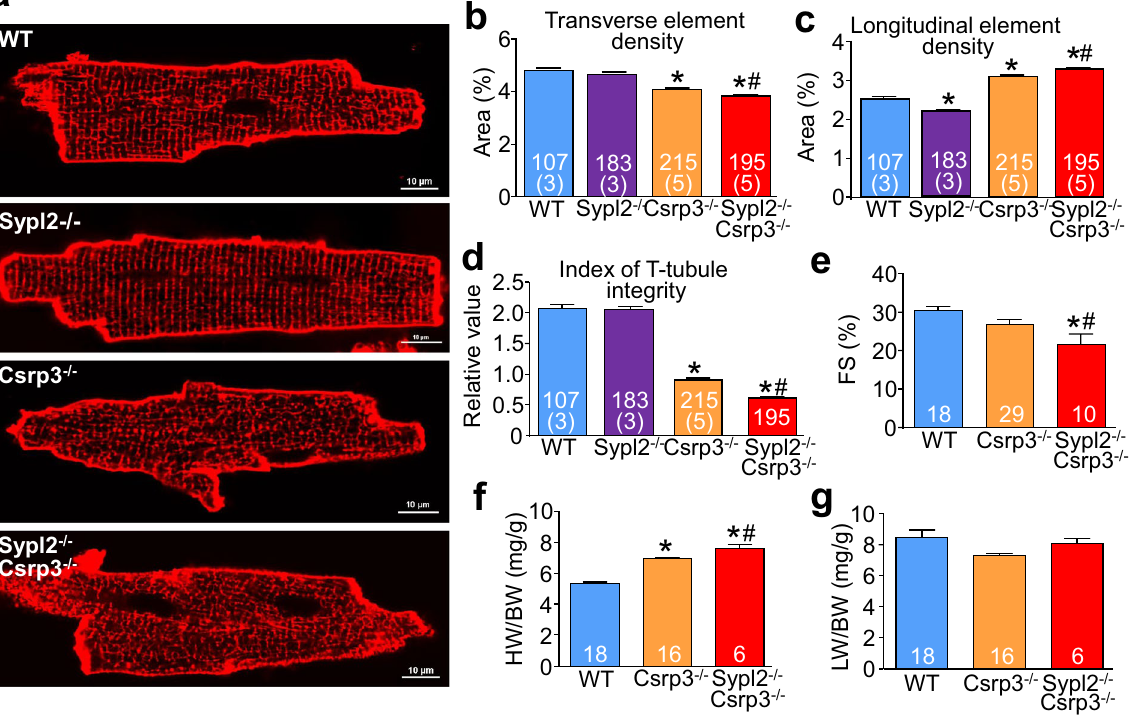
Figure 5. Loss of Mg29 accelerates heart failure progression in Csrp3 − / − mice. ( a ) Confocal images of di-8- ANEPPS-loaded cardiomyocytes isolated from Csrp3 − / − , Sypl2 − / − , Csrp3 − / − Sypl2 − / − and WT control mice. Densities of cardiomyocyte transverse t-tubule elements ( b ), longitudinal t-tubule elements ( c ), and combined measures of t-tubule integrity ( d ) were generated using AutoTT software. ( e ) Cardiac function as assessed by echocardiographic measures of fractional shortening, ( f ) heart weight normalized to body weight (HW/BW), and ( g ) lung weight normalized to body weight (LW/BW) from Csrp3 − / − , Csrp3 − / − Sypl2 − / − and WT control mice. Number of cardiomyocytes and mice analyzed is shown in the graphs. * P < 0.05 versus WT (control) group. # P < 0.05 versus Csrp3 − / −